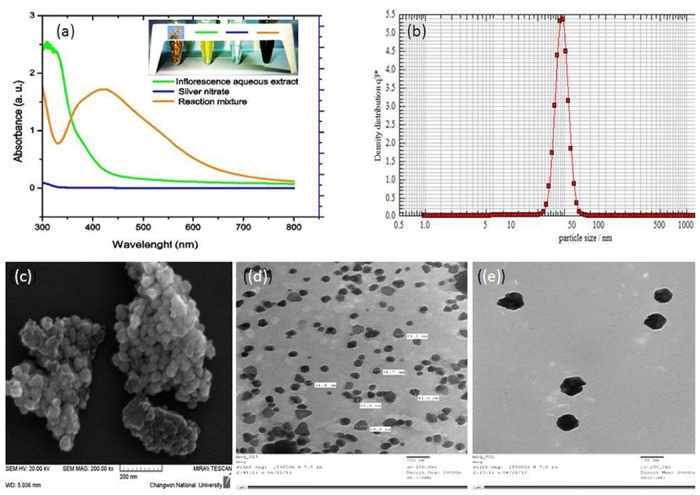
Characterization of green AgNPs (a) UV-vis spectra (b) Nanophox particles size analyzer graph (c) FE-SEM image (d) and (e) TEM images.